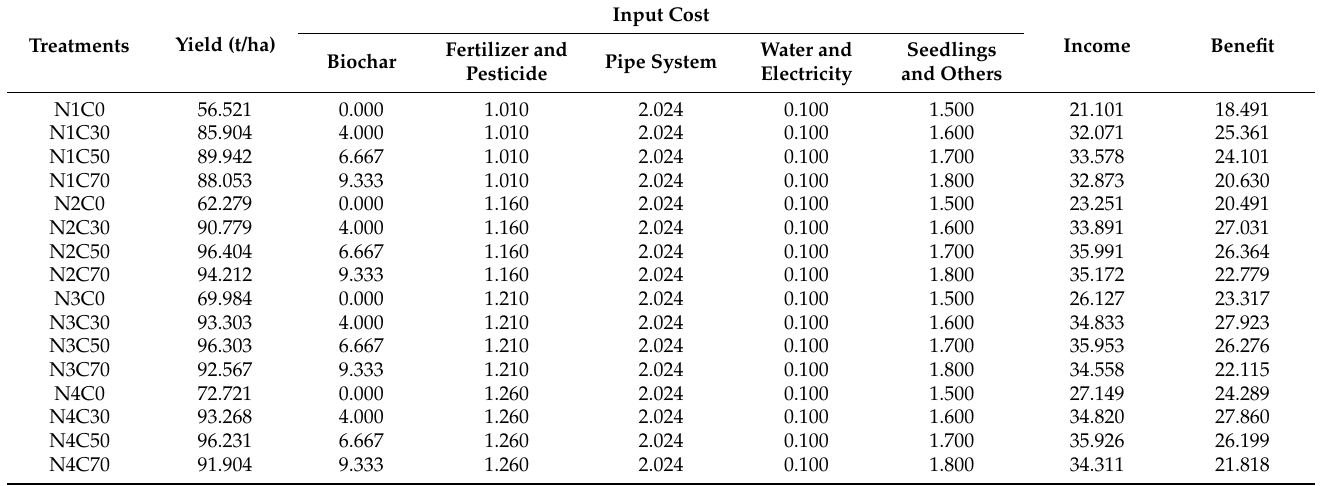
Table A1. Cost-benefit analysis of different biochar-N applications treatments for tomatoes in a single greenhouse (10 3 CNY).